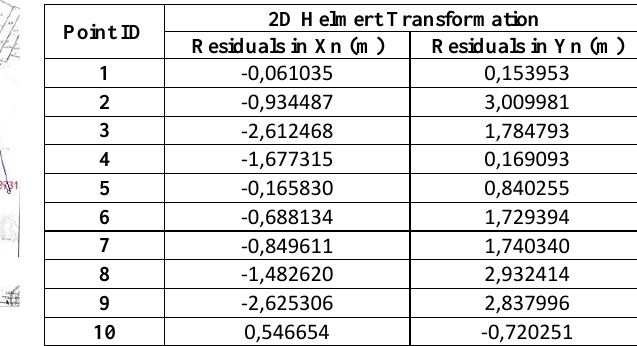
Table 6. Residuals for 2D Helmert